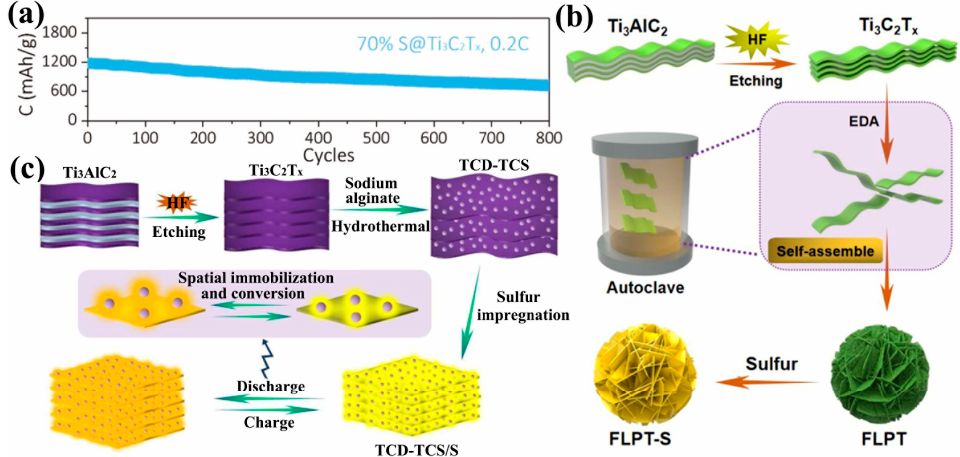
Figure 5. ( a ) Long-cycle performance of S@Ti 3 C 2 T x ink electrode at 0.2C [91]. Copyright 2018, John Wiley and Sons. ( b ) Schematic diagram of the synthesis of FLPT-S cathode [92]. Copyright 2019, American Chemical Society. ( c ) Schematic diagram of the synthesis of TCD-TCS/S cathode [93]. Copyright 2019, American Chemical